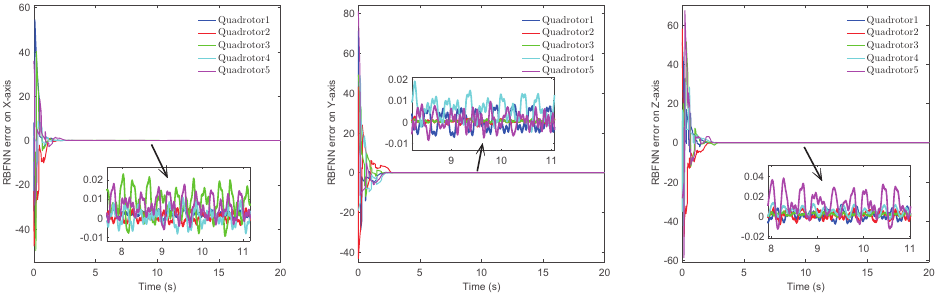
Figure 7. RBFNN approximation errors on 3 axes.